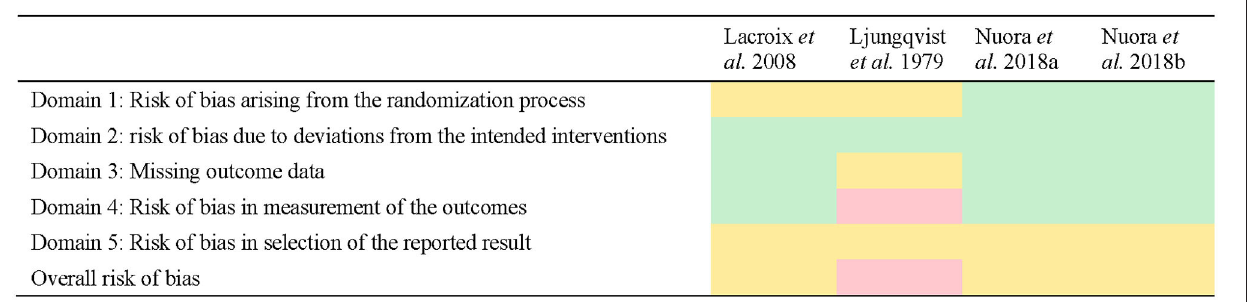
FIGURE 2 | Quality assessment of studies using the Risk of Bias 2 tool. Green indicates low risk, yellow indicates some concerns, red indicates high risk.